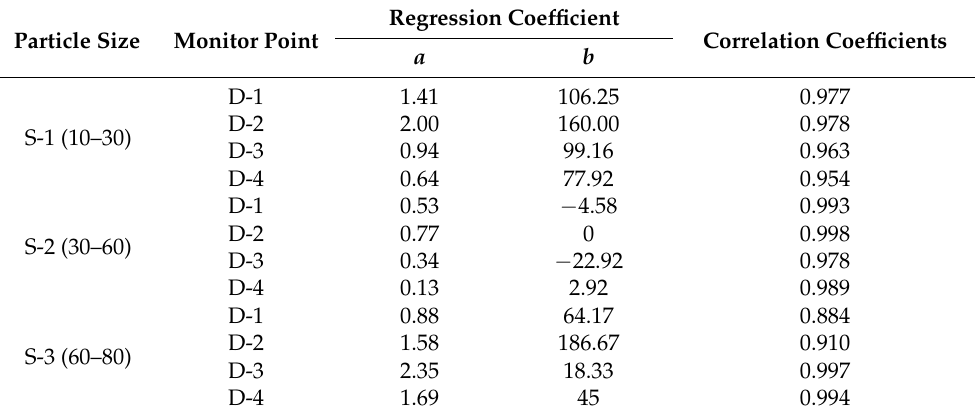
The most of correlation coefficients are greater than 0.95. Table 4. Regression coefficients of the linear relationship between axial stress and lateral stress generated by crushed mudstones.